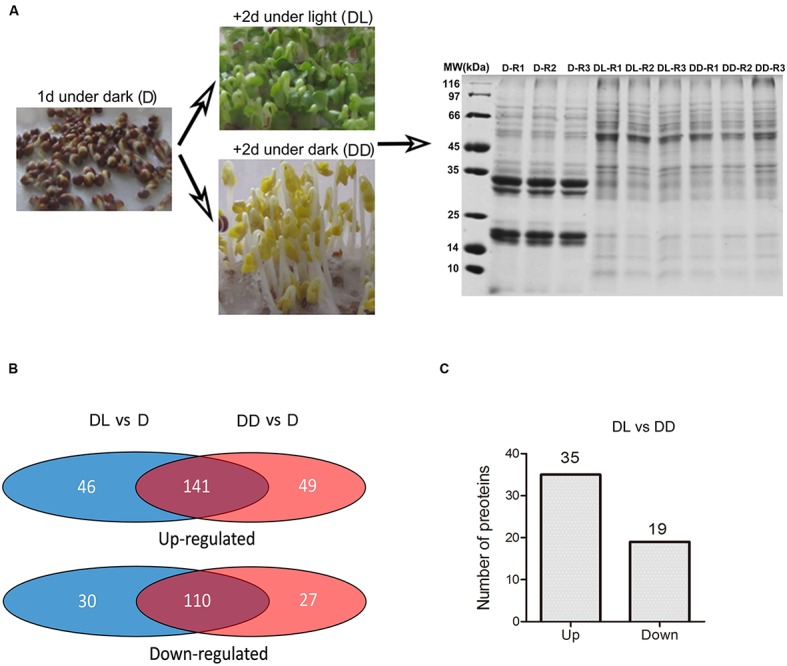
Framework for the proteome analysis. (A) Sampling and SDS-PAGE of proteins extracted from the collected samples. Three replicates were prepared for each sample. (B) Venn diagram showing the identified differentially expressed proteins. The detailed information was presented in the Supplementary Table S2. (C) Number of proteins with significant differences in expression (p < 0.05, fold change >1.5) between the DL and DD. Detailed information is presented in Supplementary Table S2.